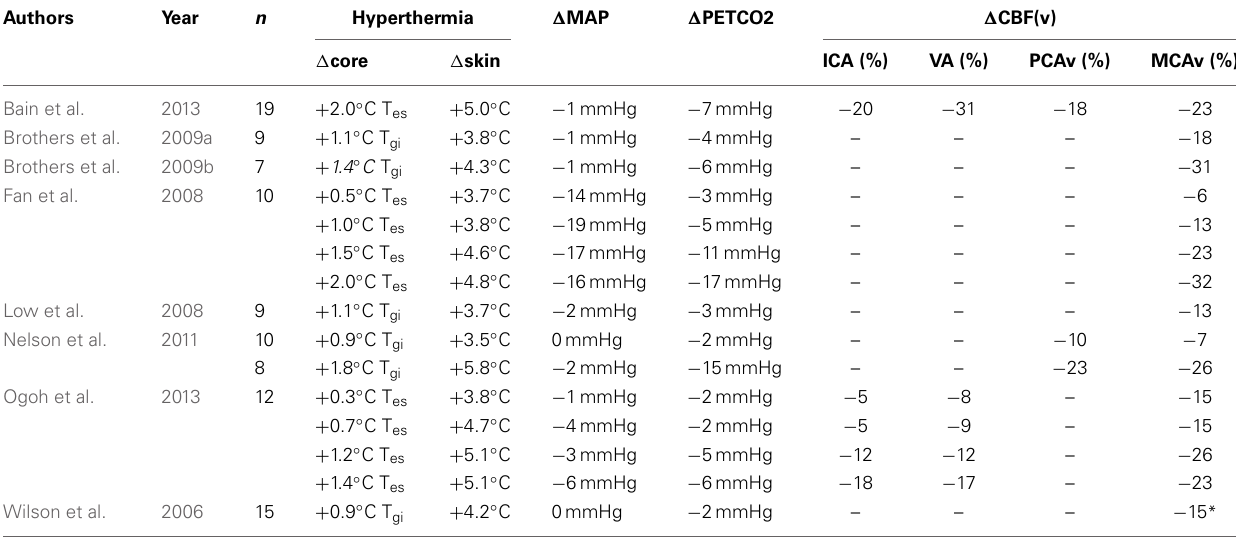
Asterisks ( * ) indicate values estimated from figure representation. T re , T es , and T gi represent rectal, esophageal, and gastrointestinal temperature respectively. n =